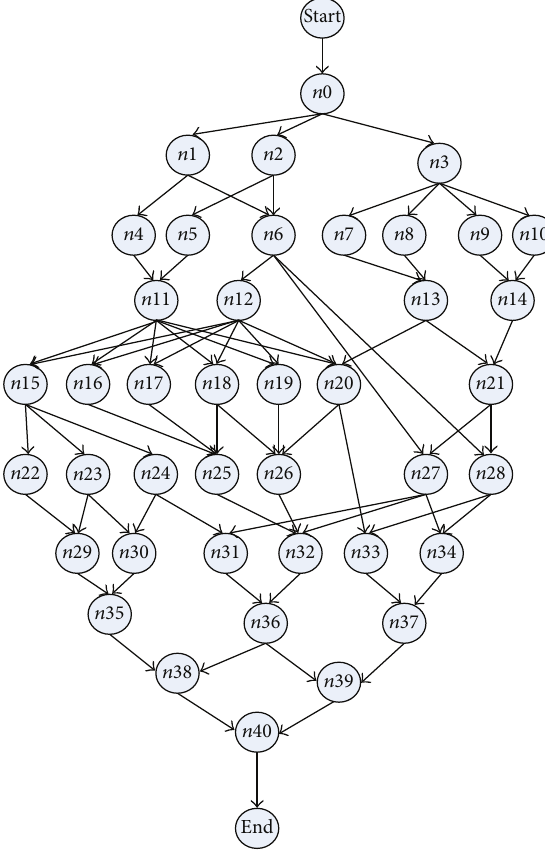
Figure 13: A molecular dynamics code.